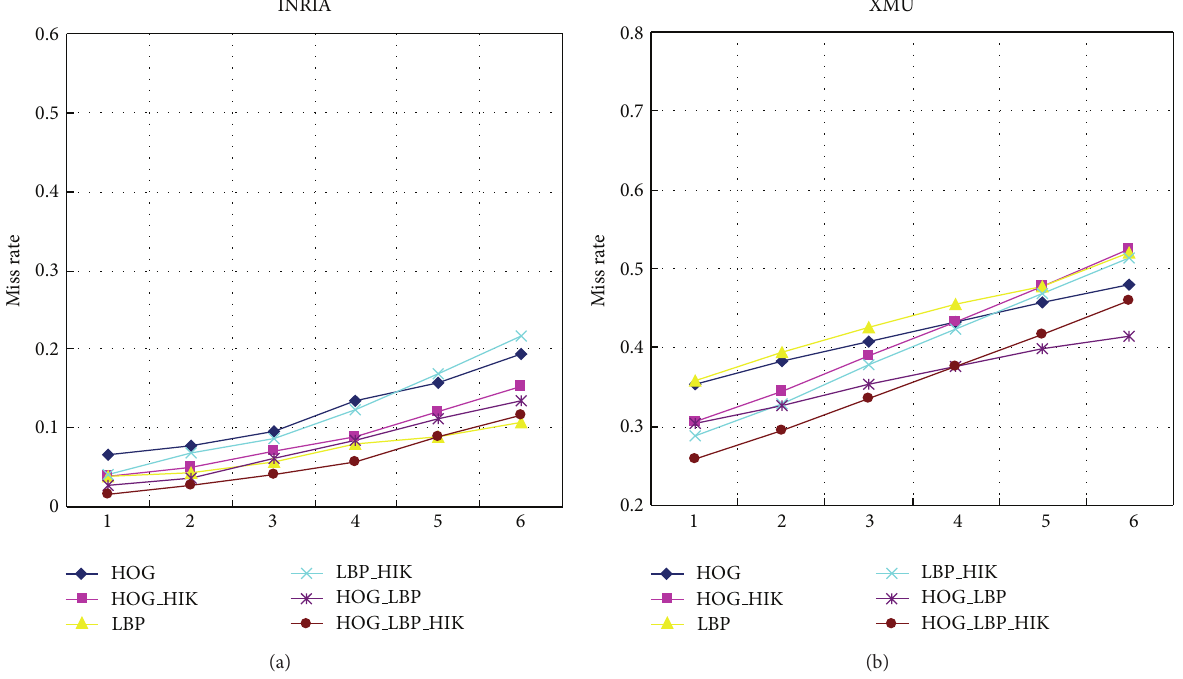
Figure 11: Examples of adding random blocks of size 16 × 16 to test-cropped images in the INRIA dataset. INRIA